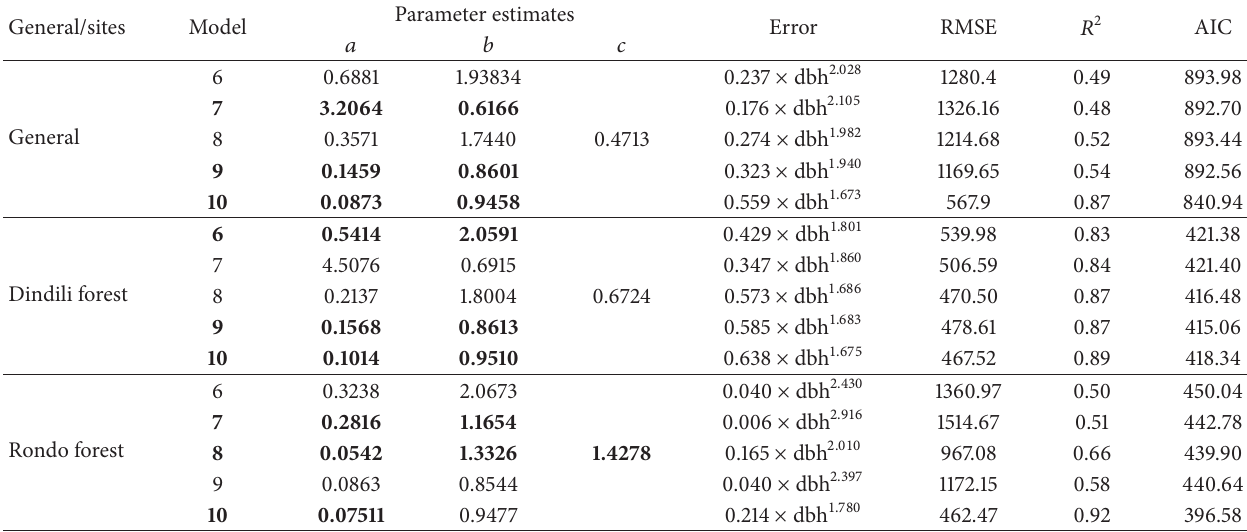
Table 5: Parameter estimates and performance of general and site specific models for total tree aboveground biomass.